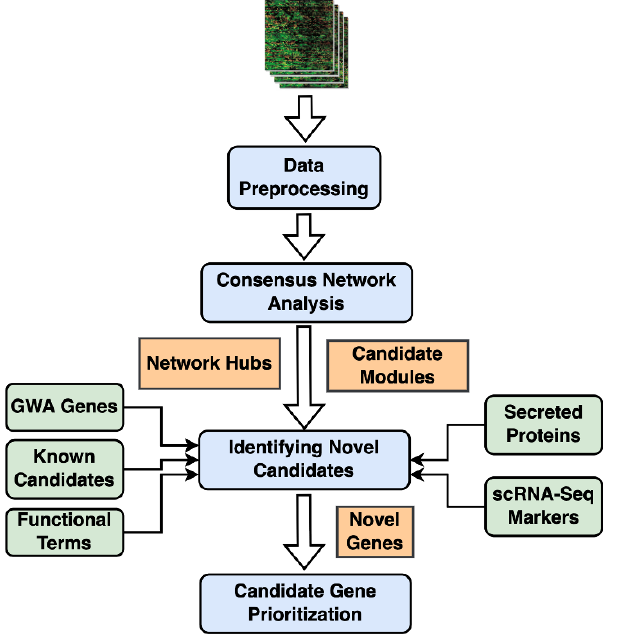
Figure 7. Schematic representation of the workflow: Transcriptomic data from the IPF and controls were downloaded from NCBI’s Gene Expression Omnibus (GEO) and used as inputs for WGCNA consensus Analysis after the necessary data cleaning and normalization steps. Consensus modules obtained from WGCNA were correlated with phenotype status and other IPF-relevant clinical traits to select candidate modules. Intramodular hub genes were identified within each candidate module and used for functional characterization and to identify novel candidates and secreted biomarkers in IPF.